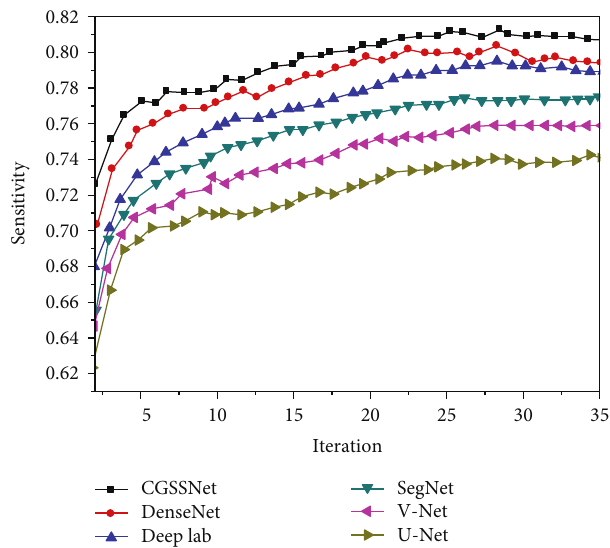
Figure 8: Comparison on Loss of di ff erent methods.